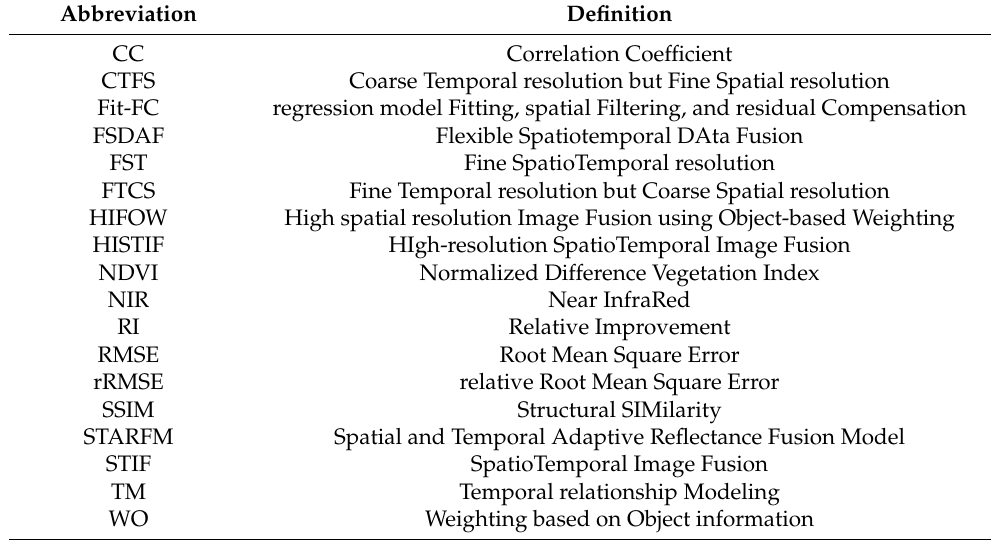
Table A1. List of